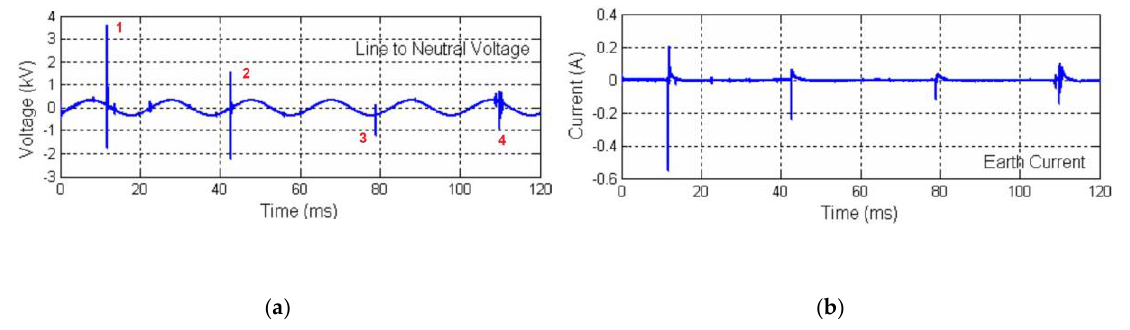
Figure 10. Measured waveforms during lightning occurrence in 4 position distance of Swedish railway facility [98]. ( a ) Line-to-neutral voltage ( b ) Local ground to rail current waveforms.